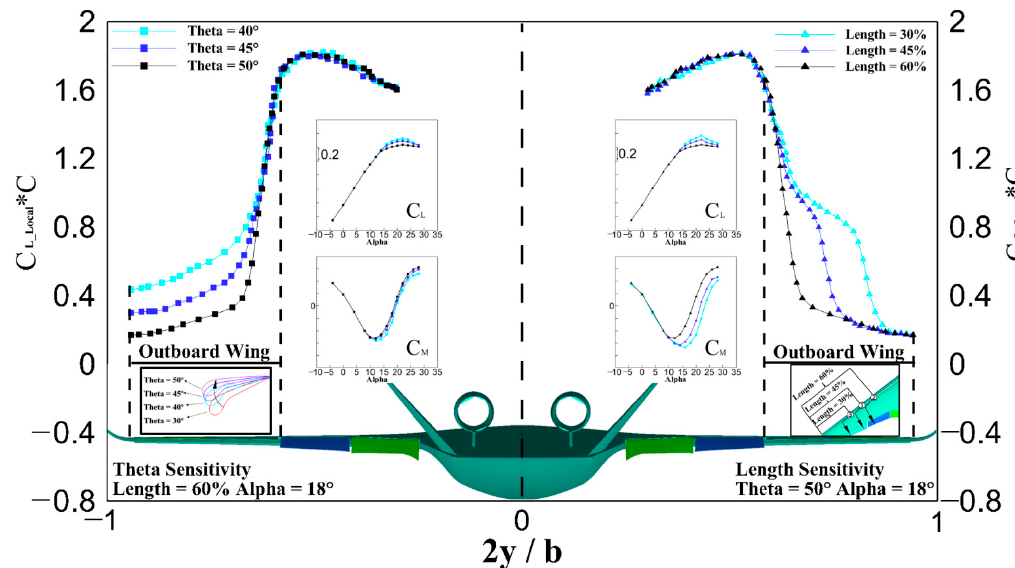
Aerospace 2022 , 8 , x FOR PEER REVIEW Figure 19. Spanwise lift distribution of the sensitivity analysis. Figure 19. Spanwise lift distribution of the sensitivity analysis.